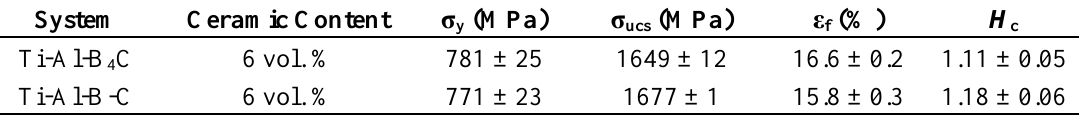
Table 2. Compression properties and work-hardening capacity ( H c ) of the in situ dual reinforcement TiB 2 -Ti 2 AlC/TiAl composites fabricated by using different